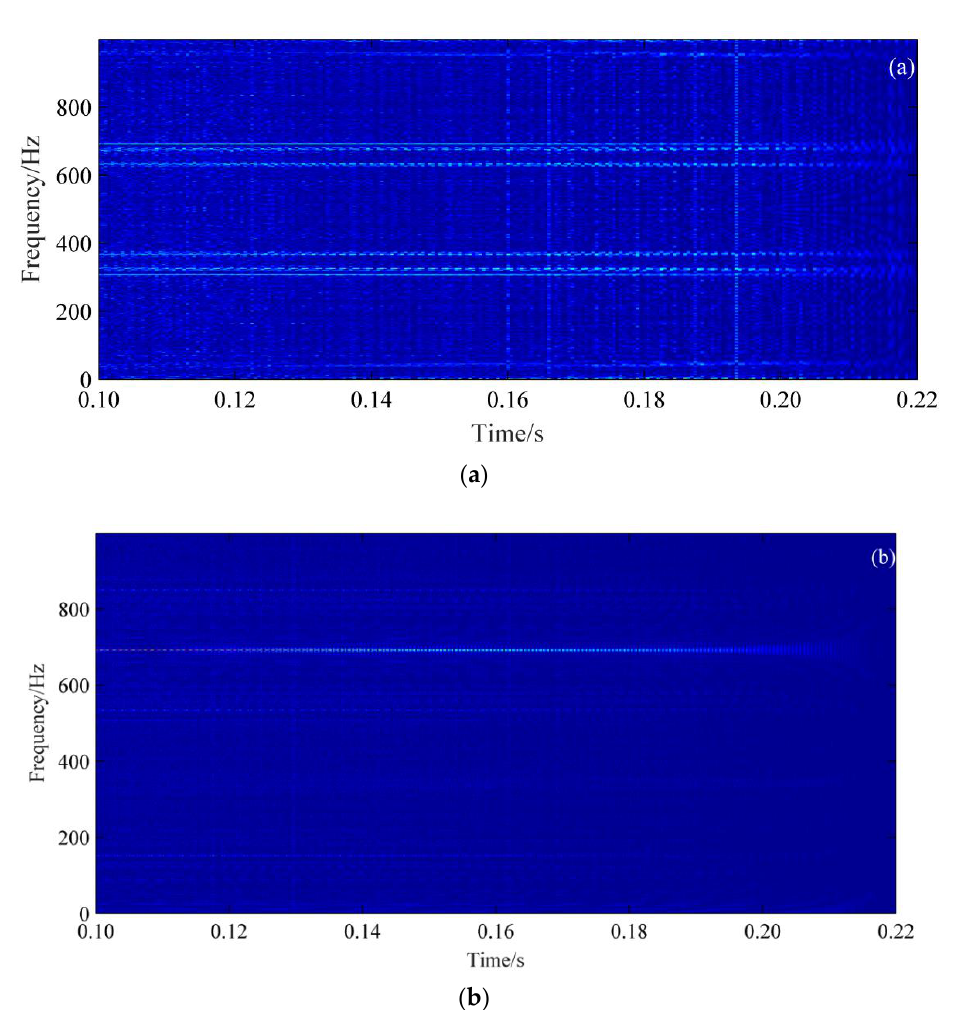
Figure 8. Spectrogram corresponding to the signal shown in Figure 7: ( a ) WVD time-frequency analytic spectrogram; ( b ) EEMD-WVD time-frequency analytic spectrogram.